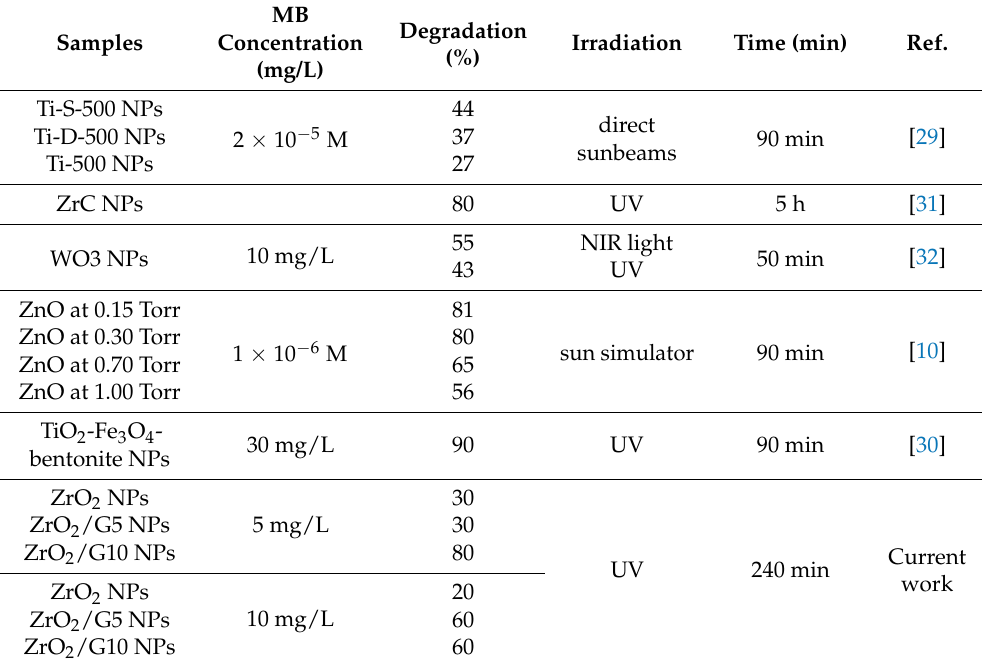
Table 5. The degradation efficiency of MB using ZrO 2 , ZrO 2 /G5, and ZrO 2 /G10 in this study was compared to previously published